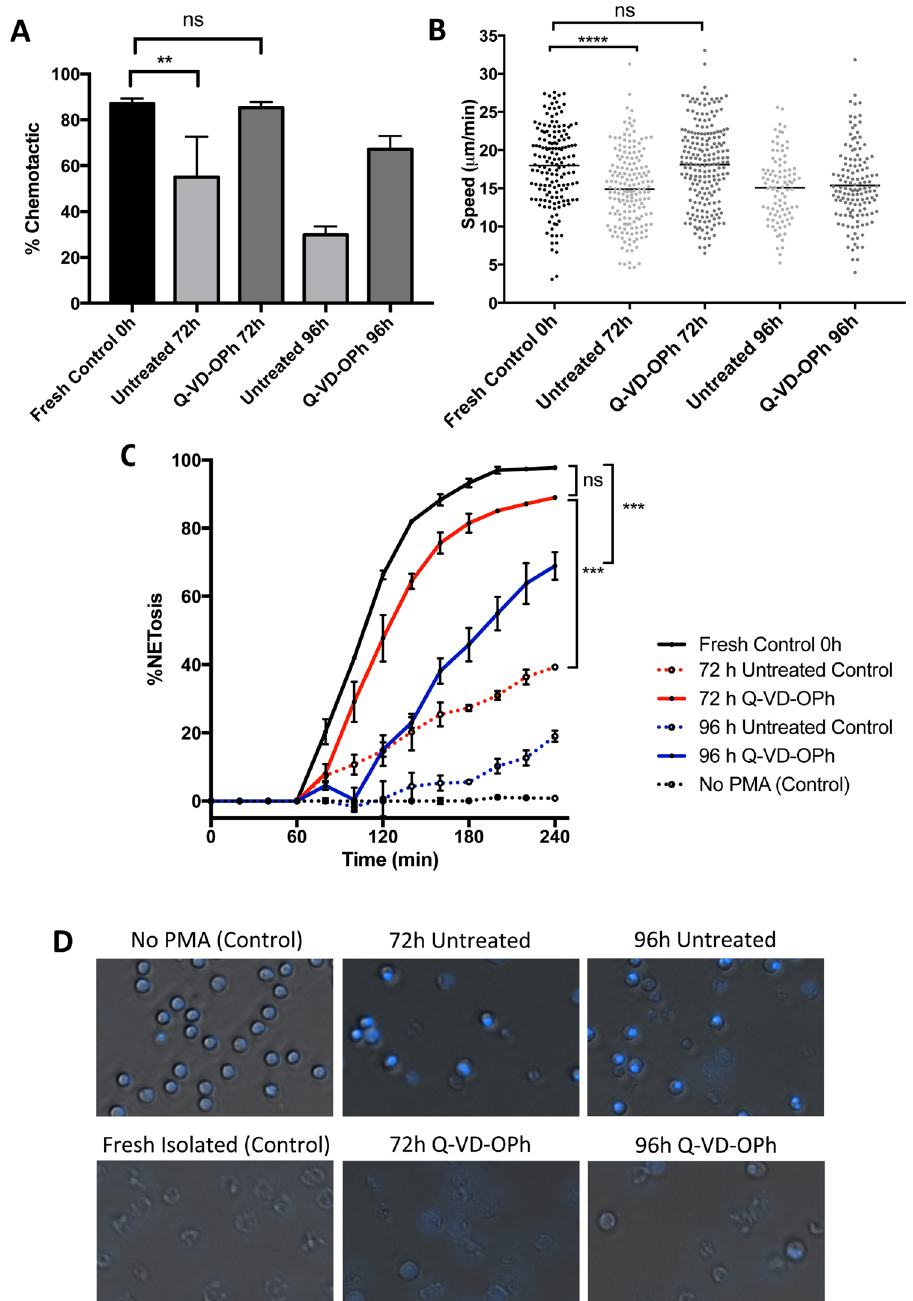
Figure 3. Ambient preservation of neutrophils. ( A ) Percent migration was established for isolated neutrophils following ambient storage (0 h v 72 h control, p < 0.01, t-test). ( B ) The migratory speed further shows that Q-VD-OPh treated cells appear indistinguishable from fresh neutrophils (0 h v 72 h control, p < 0.0001, t-test). ( C ) Following storage, the percentage of neutrophils that undergo NETosis over time in response to 10 nM PMA was quantified. Q-VD-OPh treated cells form more NETs compared to the untreated control (p < 0.001, Two-way ANOVA with Bonferroni multiple comparison post-test). The ability for Q-VD-OPh treated neutrophils to form NETs is not significantly impacted following 72 h ambient storage. ( D ) NETs formation after 240 min PMA stimulation in DAPI- stained neutrophils following 72–96 h ambient storage. All error bars represent standard deviation, n =